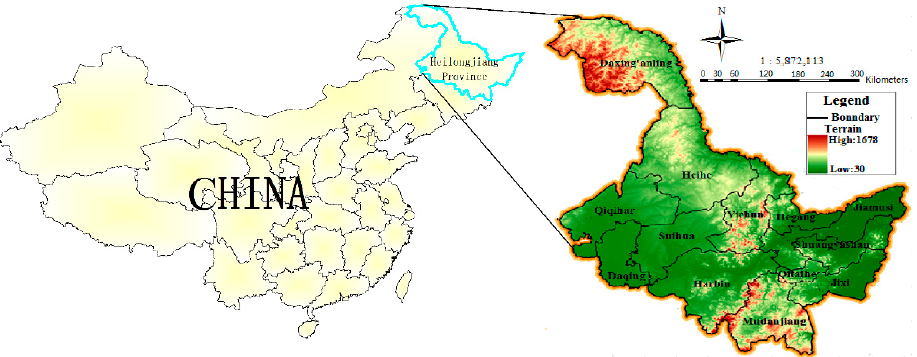
Figure 1. Heilongjiang Province location map.